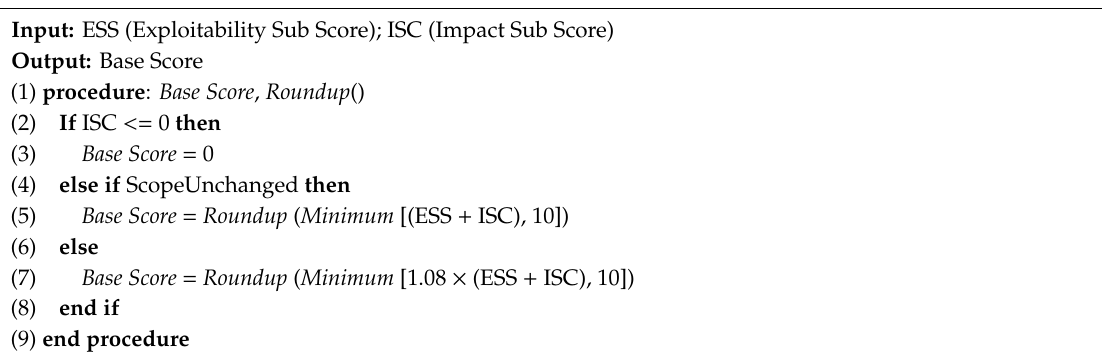
Algorithm 1. Calculate the value of the Base Score.